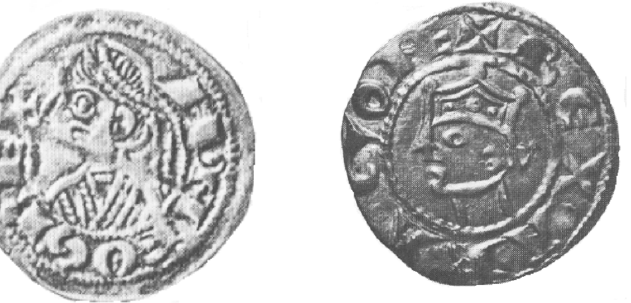
Figure 1. Dineros of Alphonse II. Aragon and Provence. Obverse. Published by Crusafont, Acuñaciones de la Corona Catalano-Aragonesa y de los reinos de Aragón y Navarra , Vico: Madrid, Spain, 1992, p. 211, nums. 141 and 139.